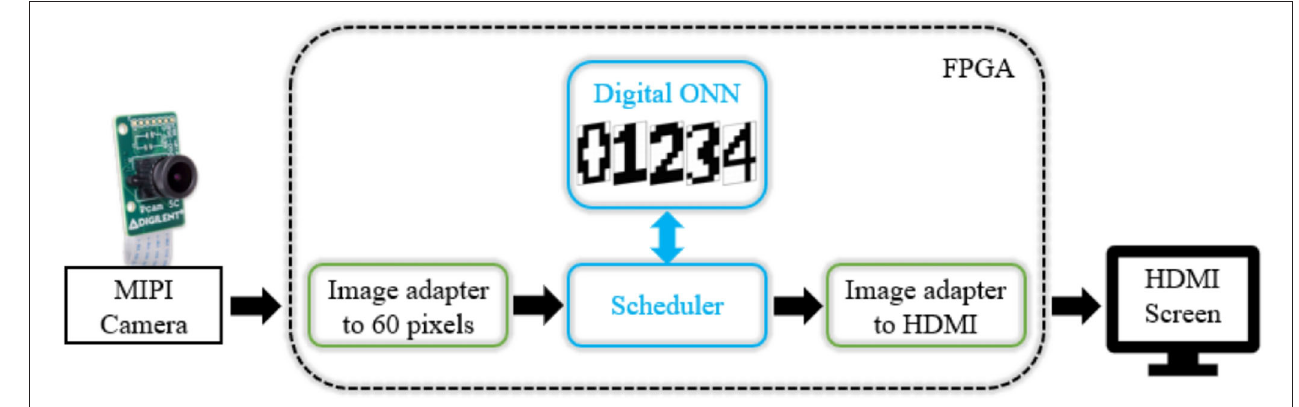
FIGURE 7 | System-level architecture for image recognition application.